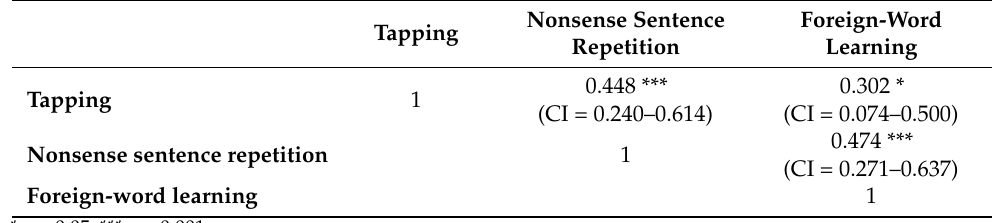
Table 2. Pearson’s correlations between tapping (N = 71), nonsense sentence repetition (N = 71) and foreign-word learning (N = 71) scores and 95% confidence intervals (CI).